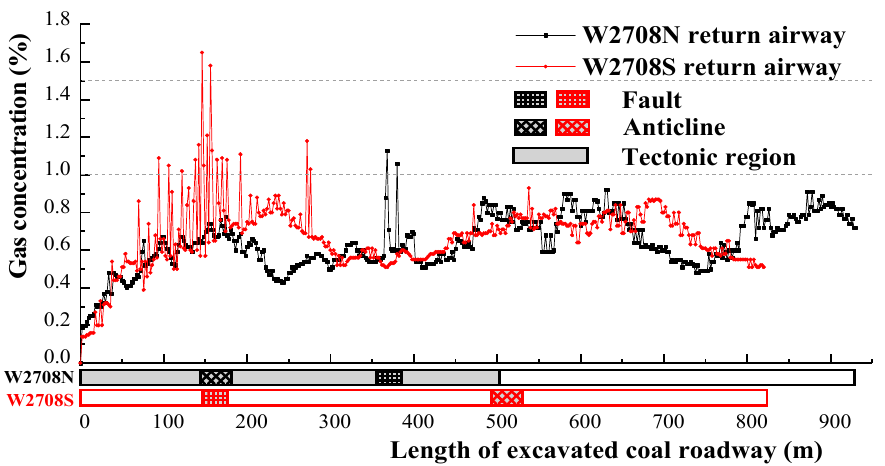
Figure 8. Gas concentration curves in the return airway.